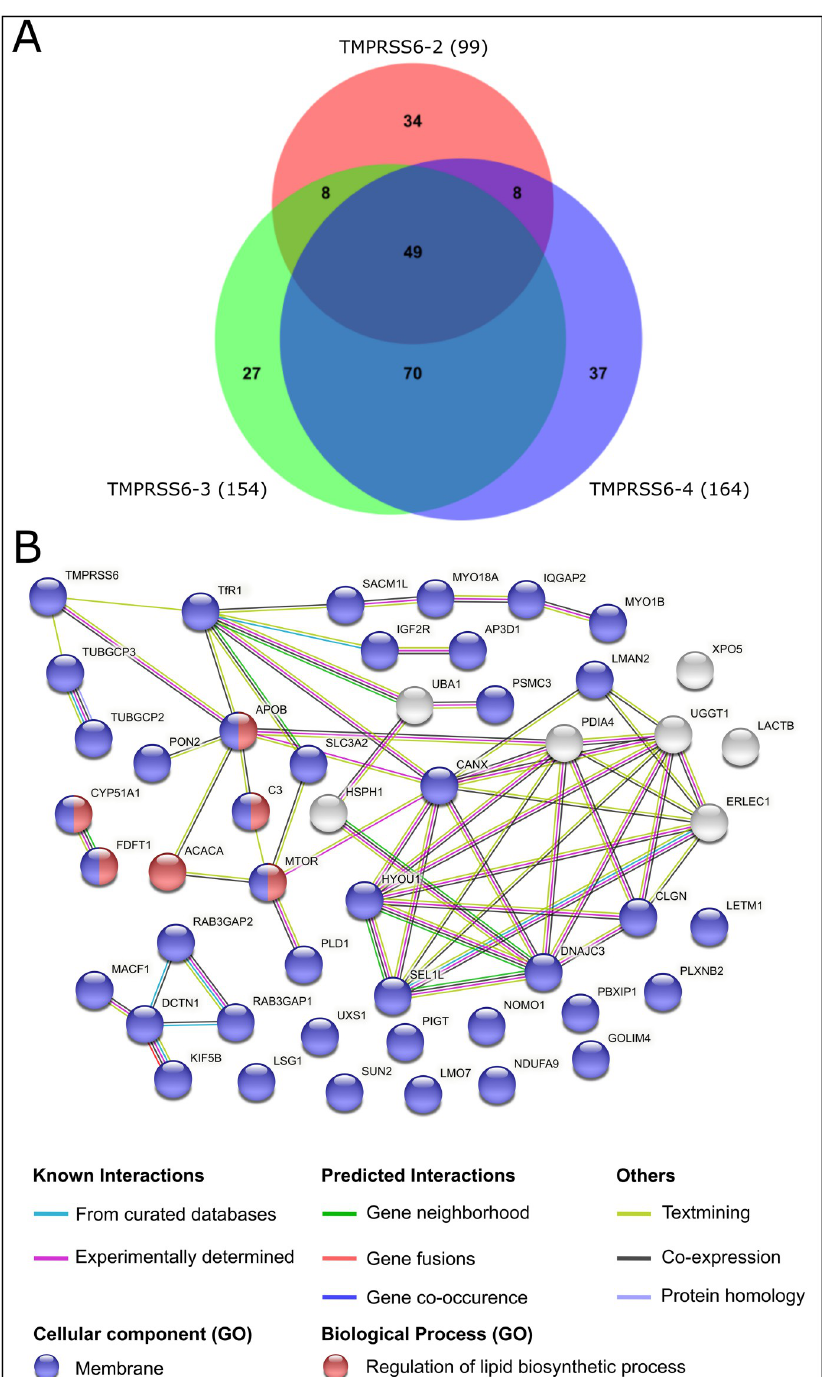
Fig 3. Identification of TMPRSS6 isoforms interacting partners. A) BioVenn overlap of TMPRSS6 isoforms 2, 3 and 4 interacting partners (fold change vs mock � 3) identified by mass spectrometry analysis of TMPRSS6 V5-tagged immunoprecipitation from transfected Hep3B cell membrane preparations. B) STRING interactome of 49 common protein partners.